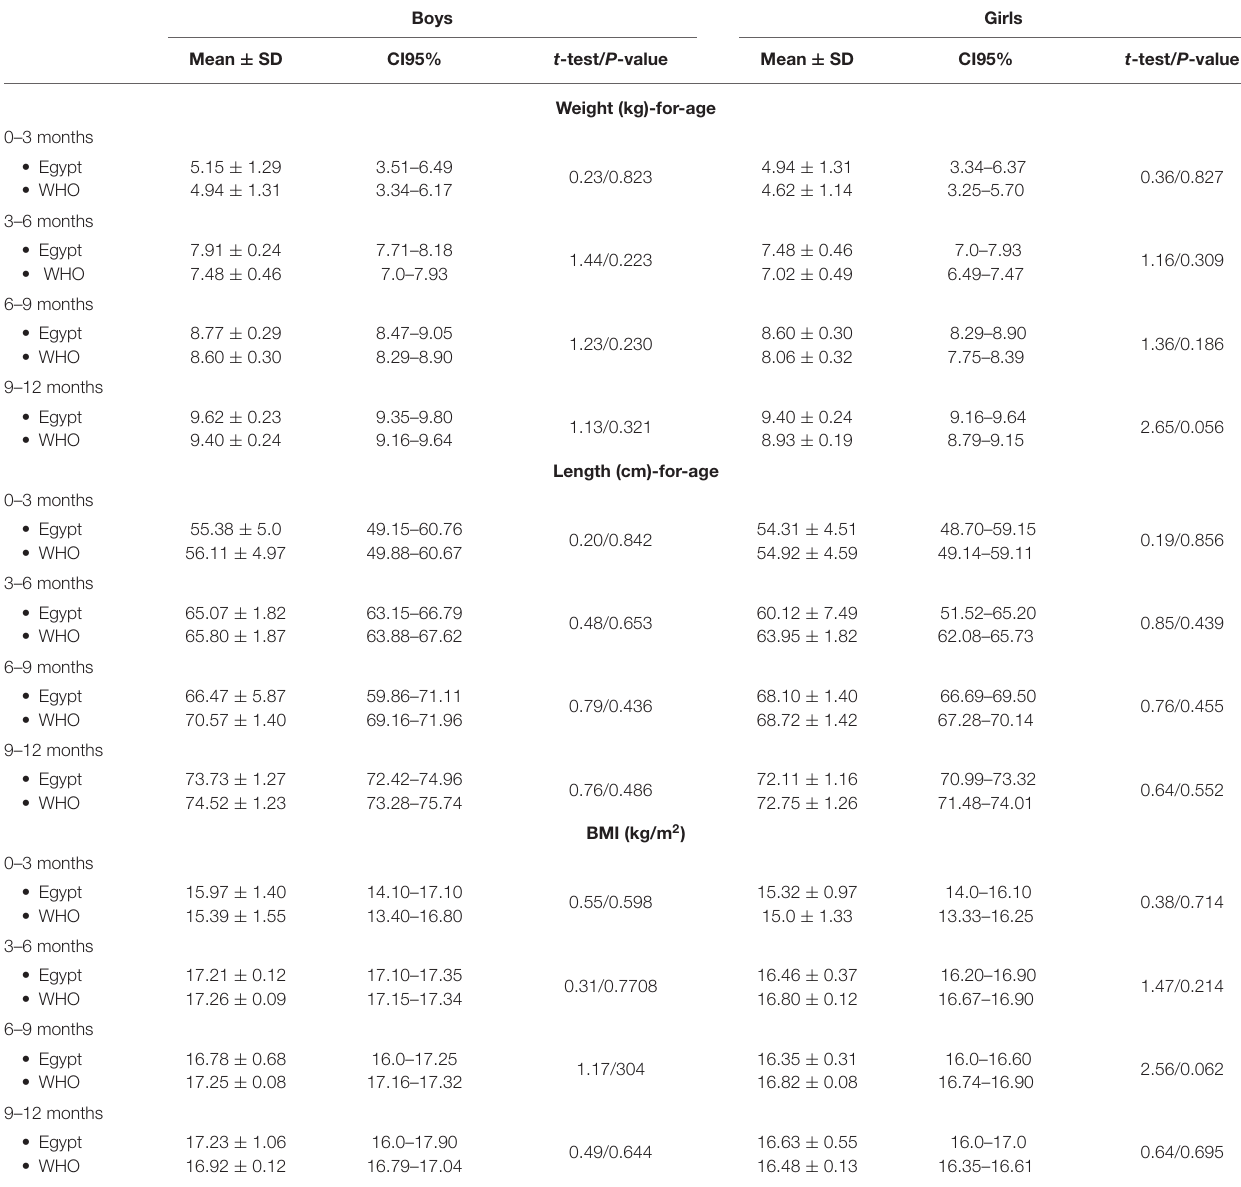
TABLE 3 | Weight for age, Length for age, and BMI for age of infants from birth up to 1 year relative to WHO growth references. Boys Mean ± SD